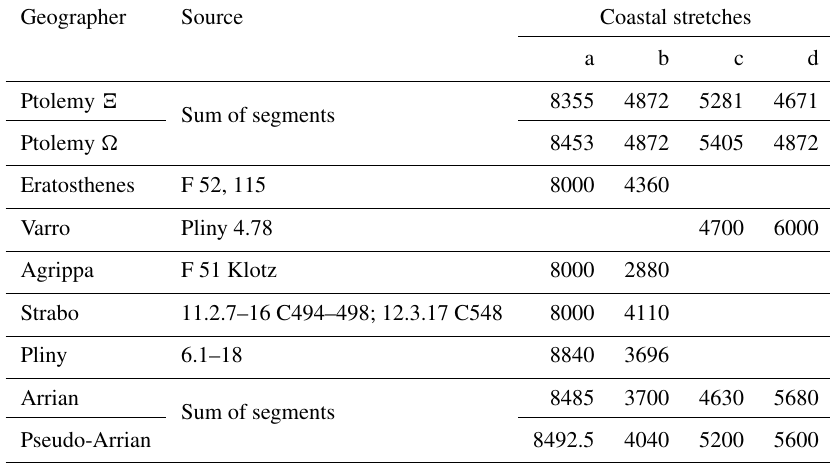
Table 2. Length of the four major coastal stretches of the Pontus according to Ptolemy and the other ancient geographers (in stades): “a” refers to the length from the Sanctuary of Artemis/Zeus Ourios to the Phasis; “b” refers to the length from the Phasis to Achilleion; “c” refers to the length from Panticapaeum to the Borysthenes; and “d” refers to the length from the Borysthenes to the Sanctuary of Artemis/Zeus